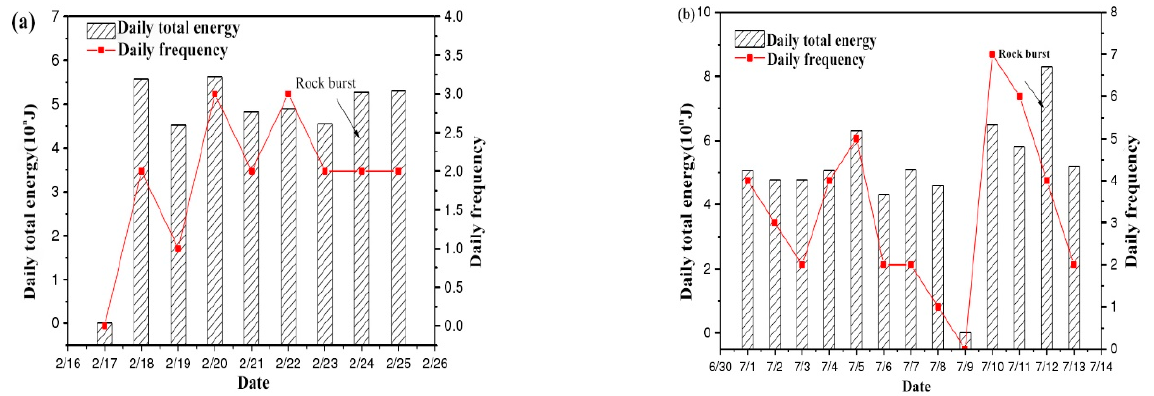
Figure 6. ARAMIS M/E microseismic rule of rockburst. ( a ) On 24 February 2014; ( b ) On 12 July